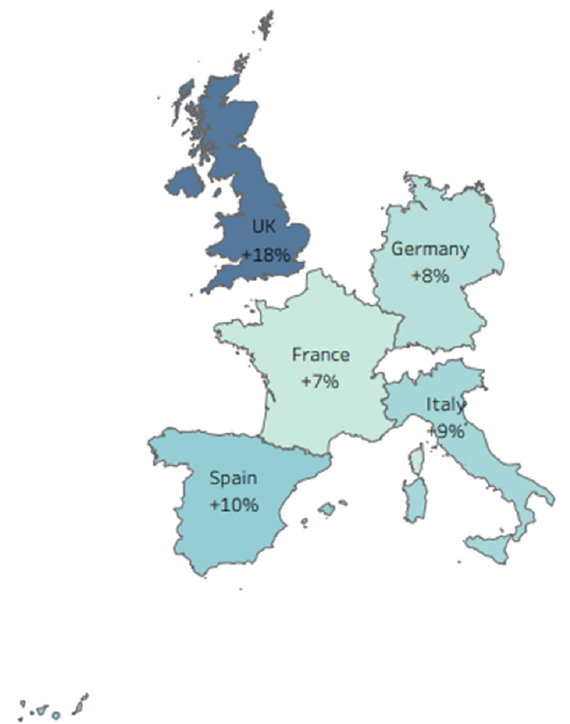
Figure 3. Mean estimates of the increase in IVE in the absence of egg adaptations for “all strains” per country (TIV and QIV only). The figure was developed using Tableau